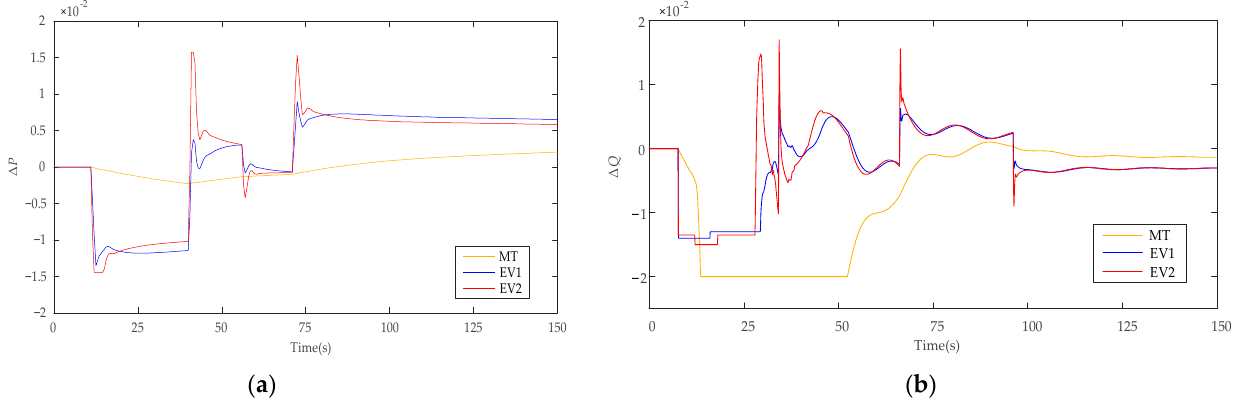
Figure 18. Power variations of each equipment under load power disturbance: ( a ) active power increment; ( b ) reactive power increment.